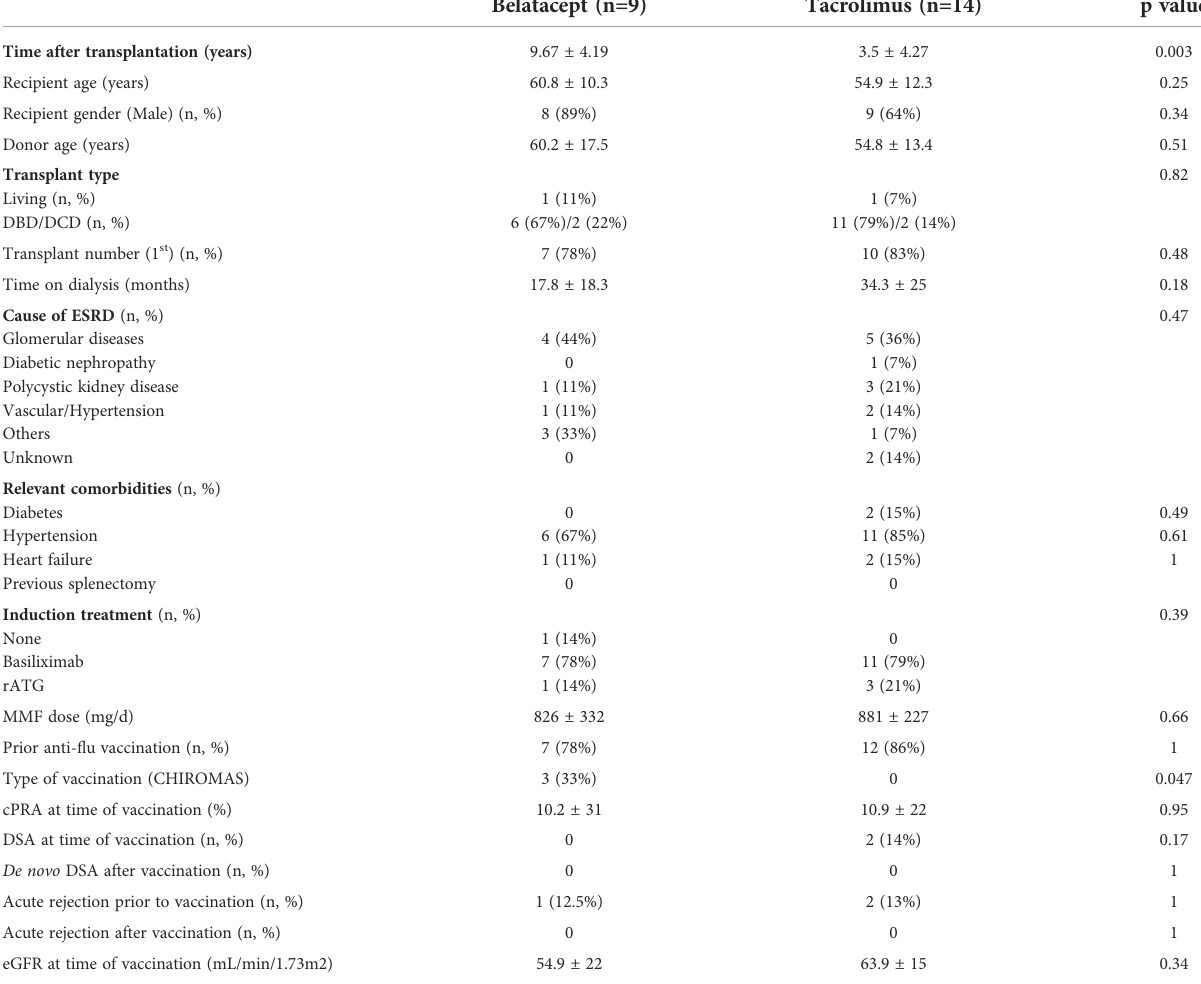
TABLE 1 Main characteristics of the study